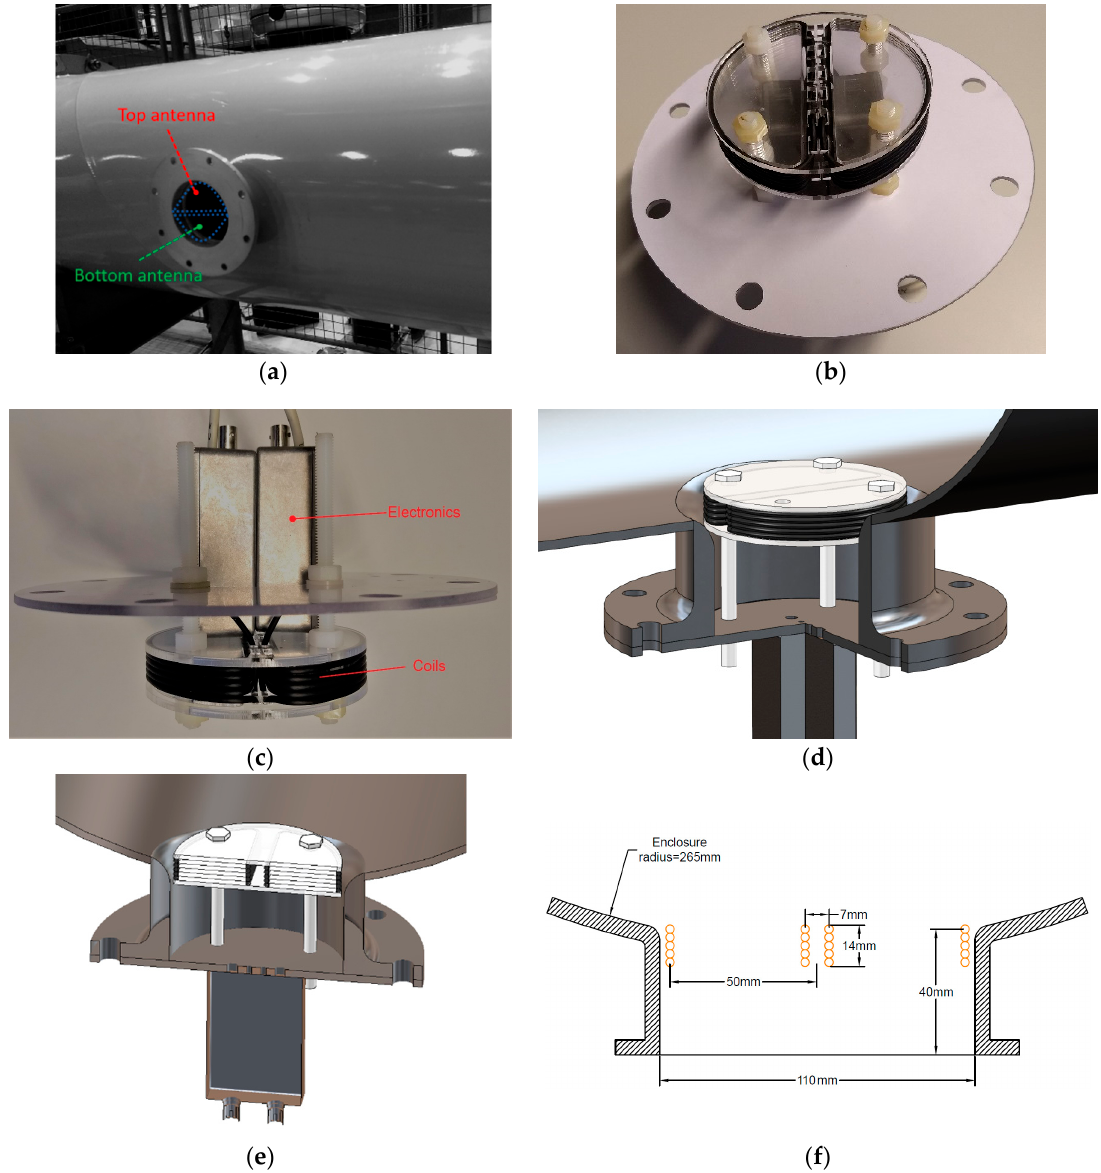
Figure 8. ( a ) Gas insulated system (GIS) enclosure and dielectric window opening and pick-up coils direction in dielectric window ( b ) Magnetic antenna; ( c ) magnetic antenna detail; ( d ) perspective view of magnetic antenna installation; ( e ) cutaway view of magnetic antenna installed in the GIS compartment; ( f ) axial cross section of the dielectric window and the antenna coils with dimensions.